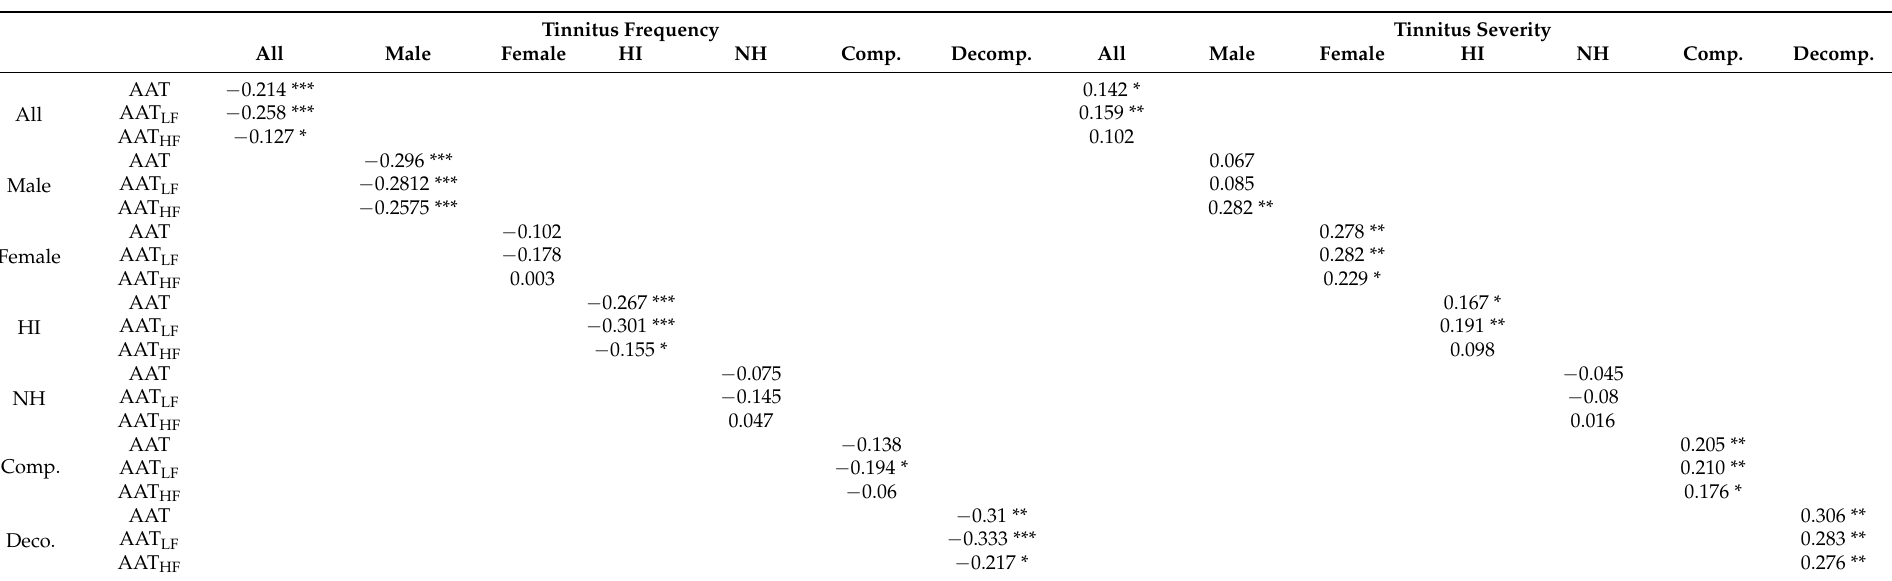
Table 5. Correlation coefficients between average auditory threshold, tinnitus frequency, and tinnitus severity. Comp. and decomp. stand for compensated and decompensated tinnitus, respectively.